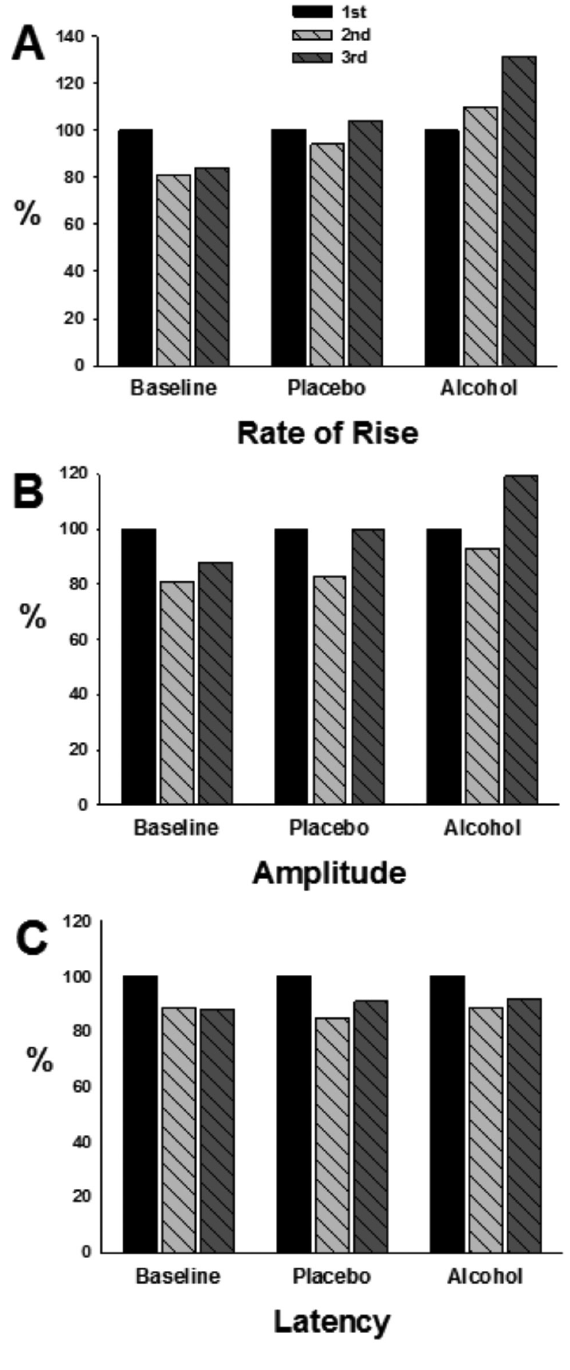
Figure 3 - Percentage of change of the P2 rate of rise (A) , amplitude (B) and peak latency (C) according to the order of presentation (1 st , 2 nd and 3 rd ) of the P2 waves on the train. The measures of the first waves were normalized as 100% in all cases. Baseline is the pre-drug condition and Placebo and Alcohol are the